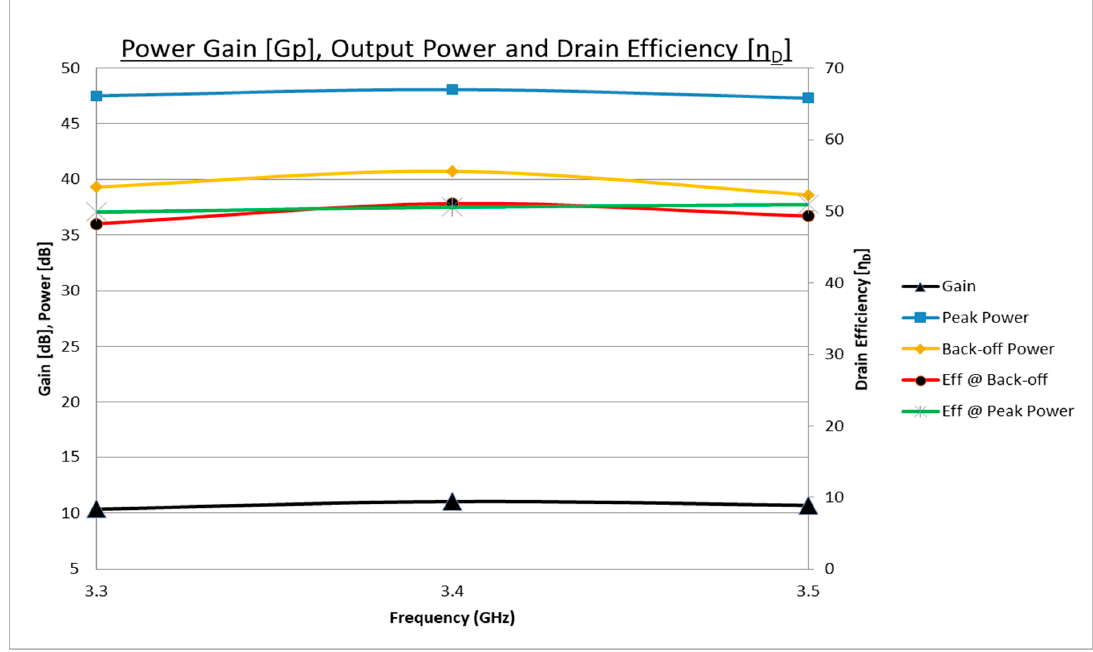
Figure 13. Measured performance of the designed Doherty amplifier verses selected frequencies.